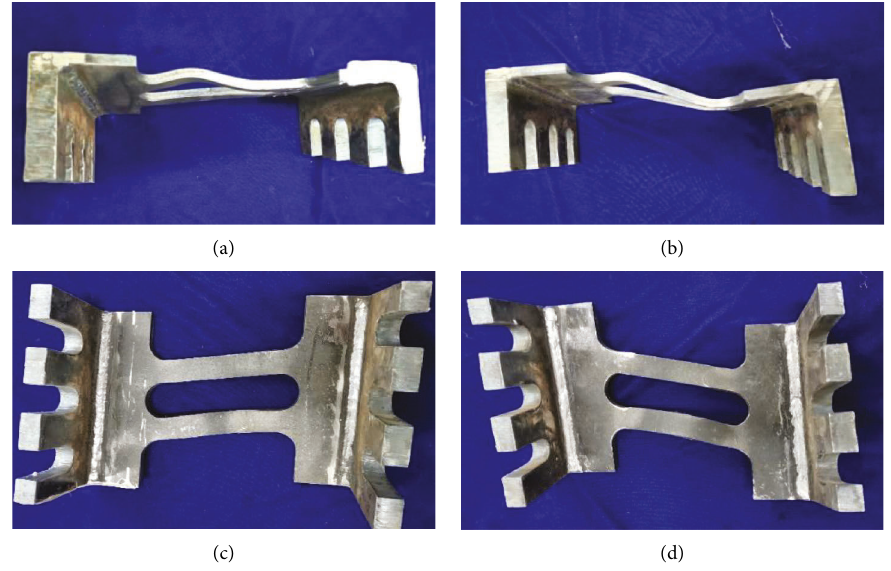
Figure 12: The failure of RED after testing. (a) Lateral view 1. (b) Lateral view 2. (c) Front view 1. (d) Front view 2.